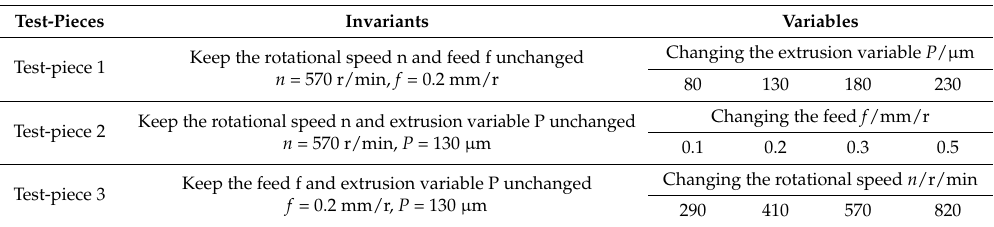
Table 4. Processing parameters of ultrasonic extrusion.